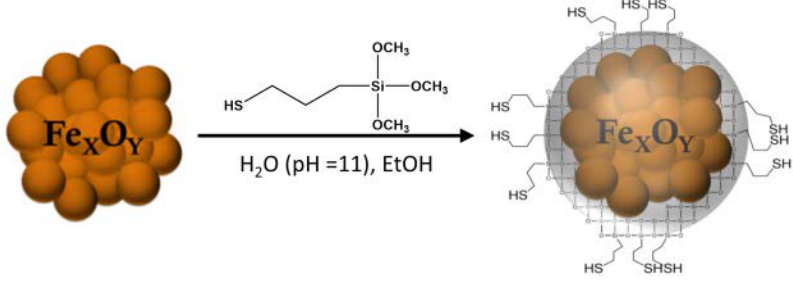
Scheme 1. Surface functionalization of magnetic multicore nanoparticles (MCNP)